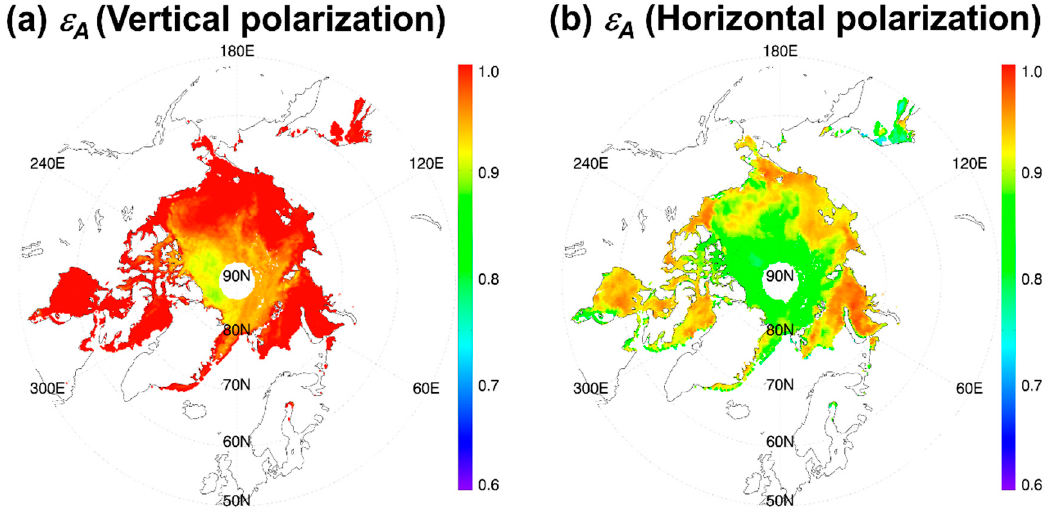
Figure 1. Geographical distributions of the retrieved ( a ) vertically and ( b ) horizontally polarized apparent emissivities at 19.4 GHz of SSM/I on 1 January 2004.